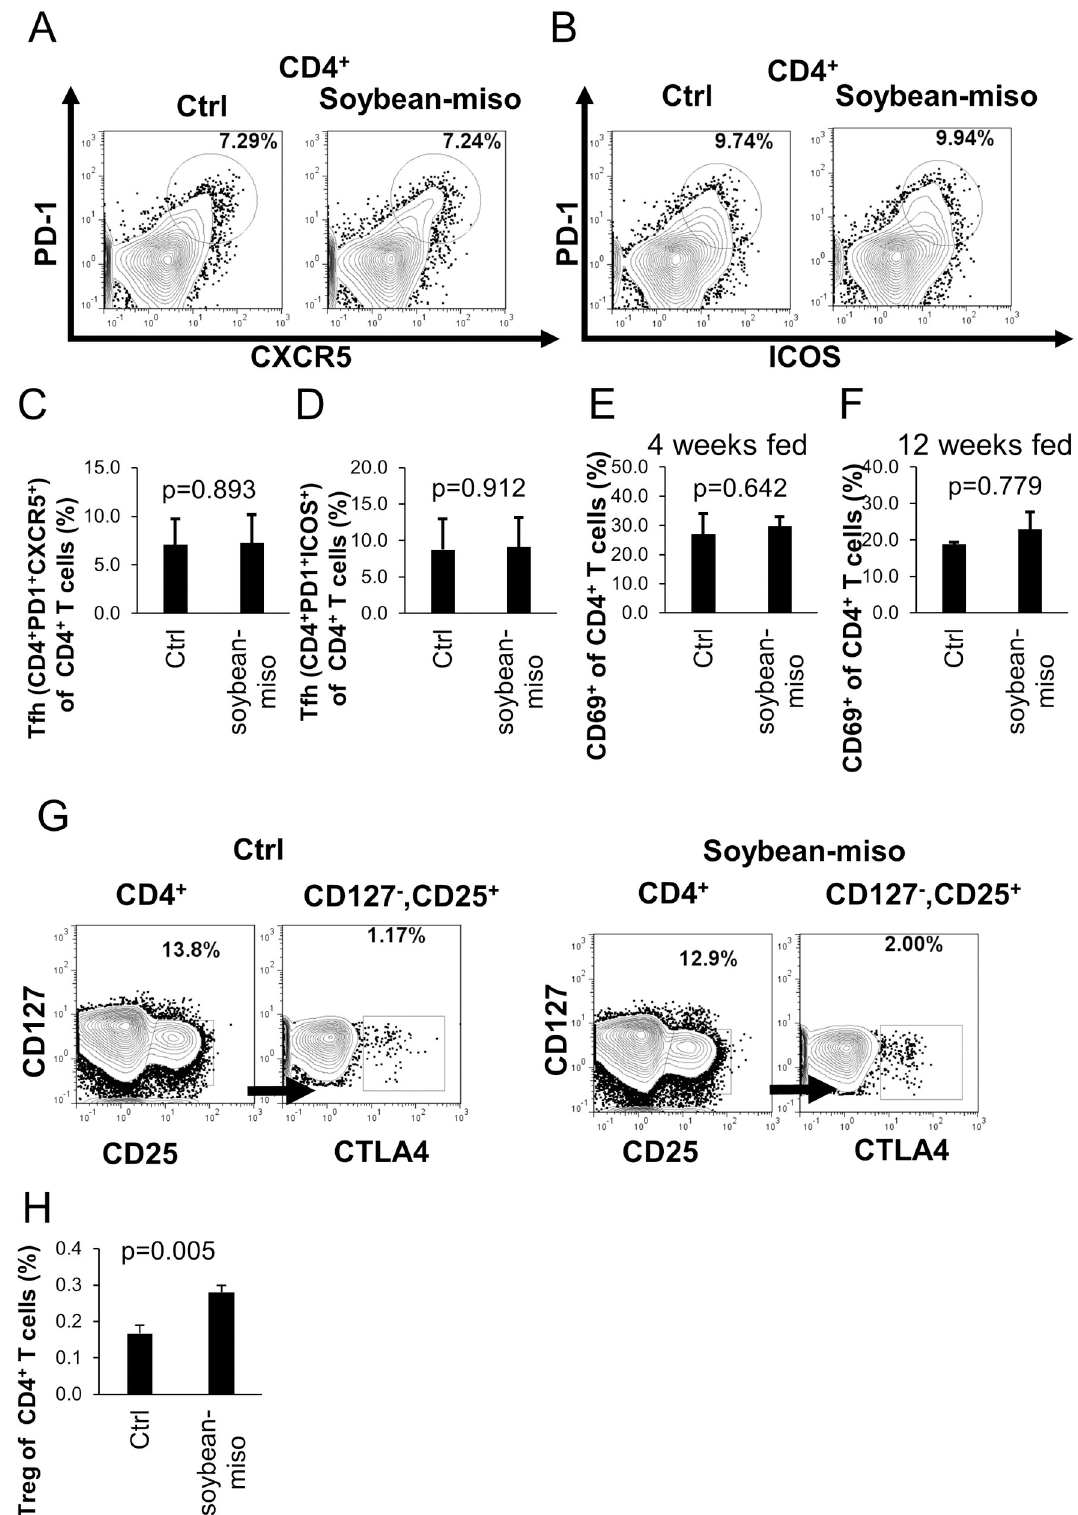
Fig 2. The effect of miso on subsets of T cells in mouse spleens. (A) Examples of the measurement of Tfh (CD4 + PD-1 + CXCR5 + ) by flow cytometry are shown. (B) Examples of the measurement of Tfh (CD4 + PD-1 + ICOS + ) by flow cytometry are shown. (C) The